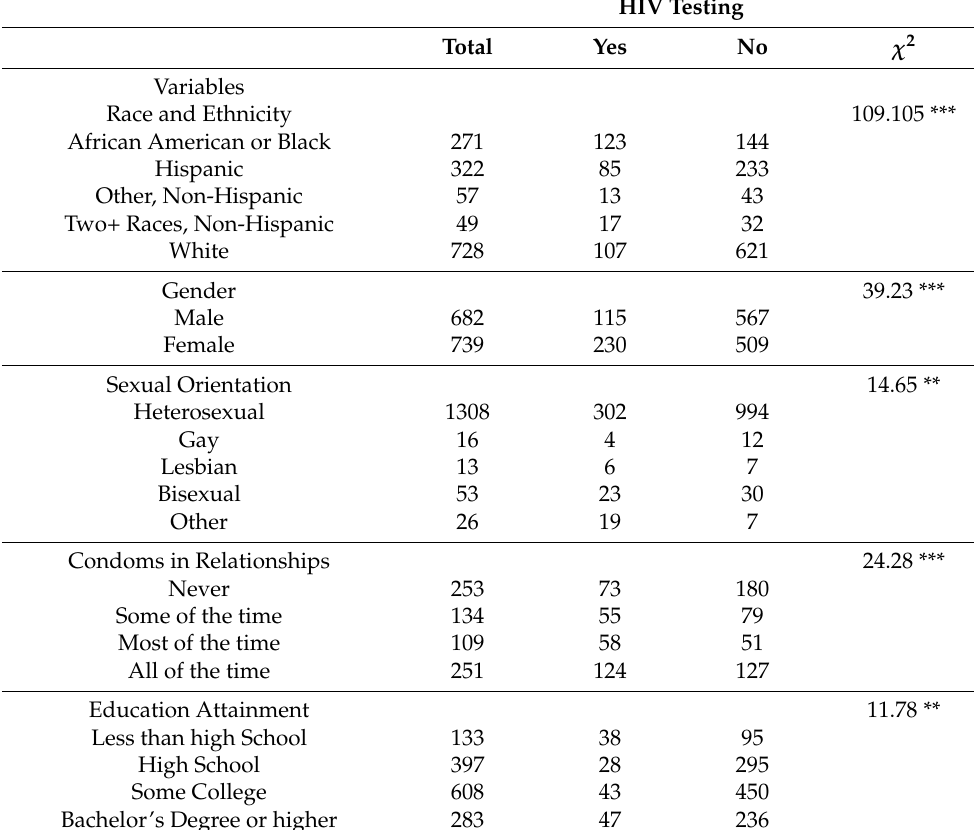
Table 3. Sample Characteristics compared by HIV Testing (N =